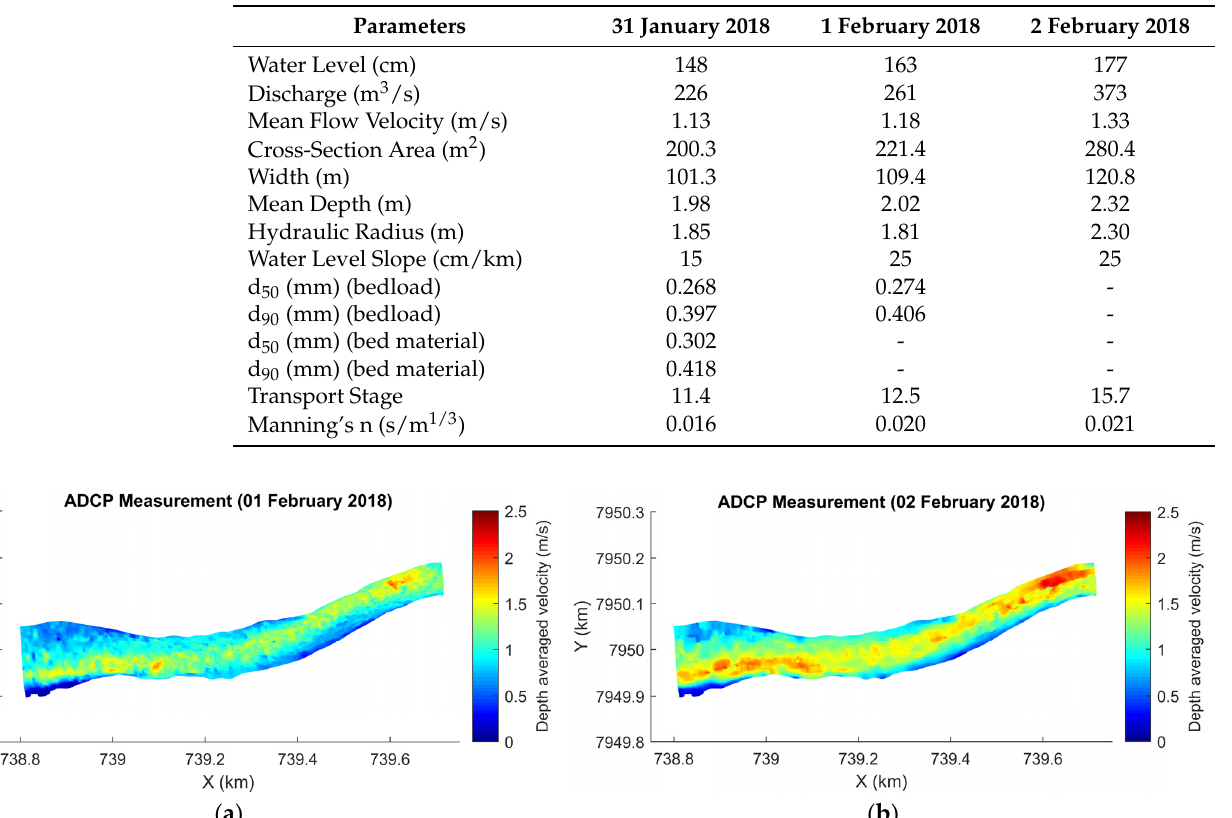
Figure 7. Flow velocity measured with ADCP at cross-section P1 on 1 February 2018. Vertical black lines are the positions of moving-bed tests and where bedload samples were collected. Table 3. Measured and estimated hydraulic parameters at Taquari River, cross-section P1.